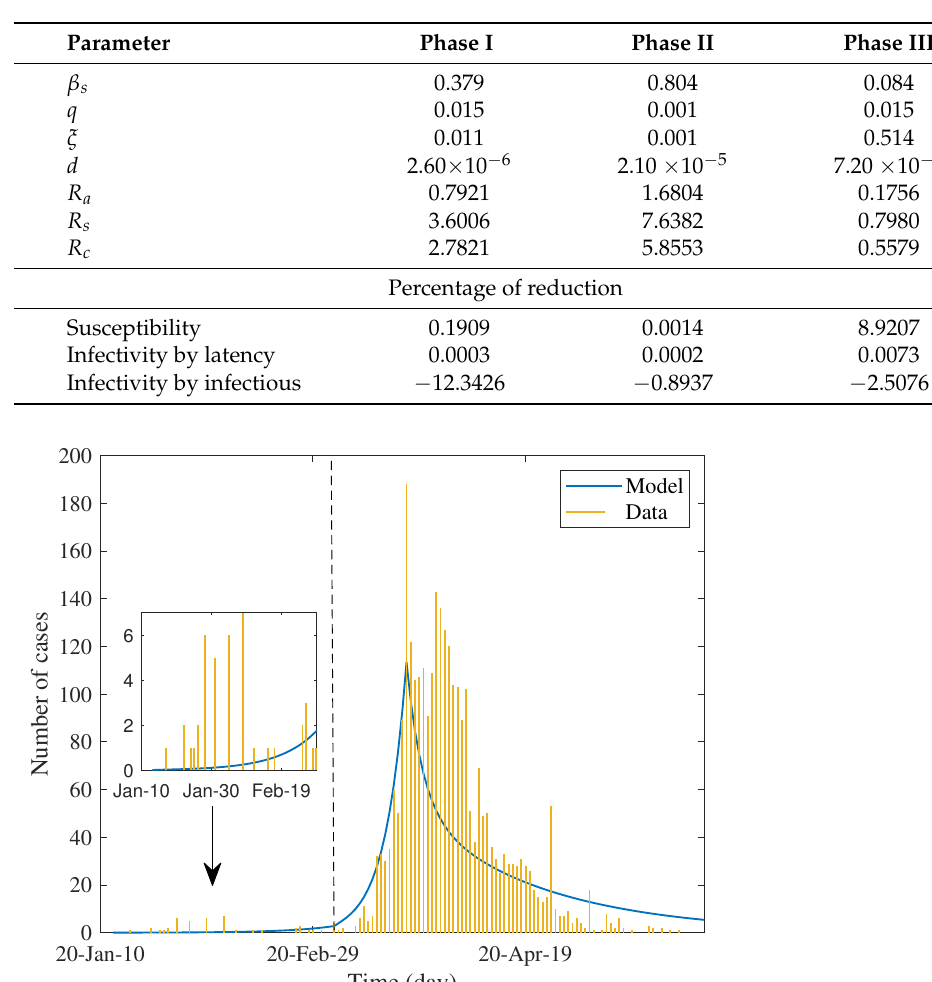
Figure 2. Fitting daily reported cases over a six-month period of the first wave. Small bars represent the data and solid lines present the models. The vertical dashed line indicates the boundary between phase I and II, while the peak indicates the beginning of phase III. Inset shows minor epidemics in phase